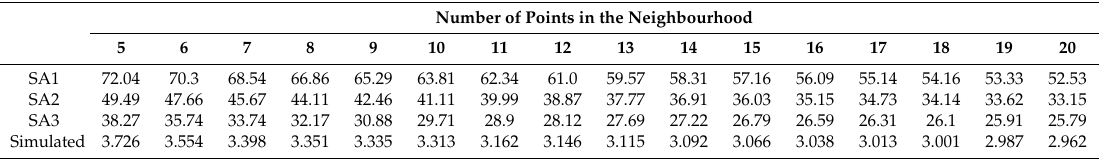
Table 12. RMSE of the aspect (degrees) extracted from the interpolated DEM of study areas 1–3 and simulated